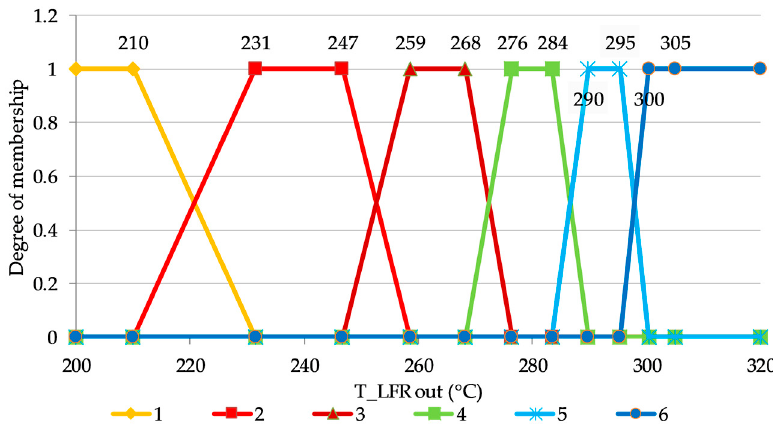
Figure 4. Number of working modules by varying the solar field output oil temperature.